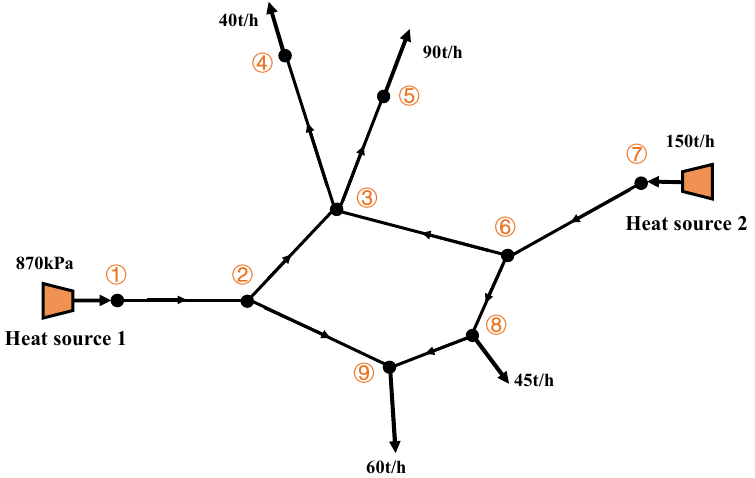
Figure 13. Nine-node double-heat-source ring network.